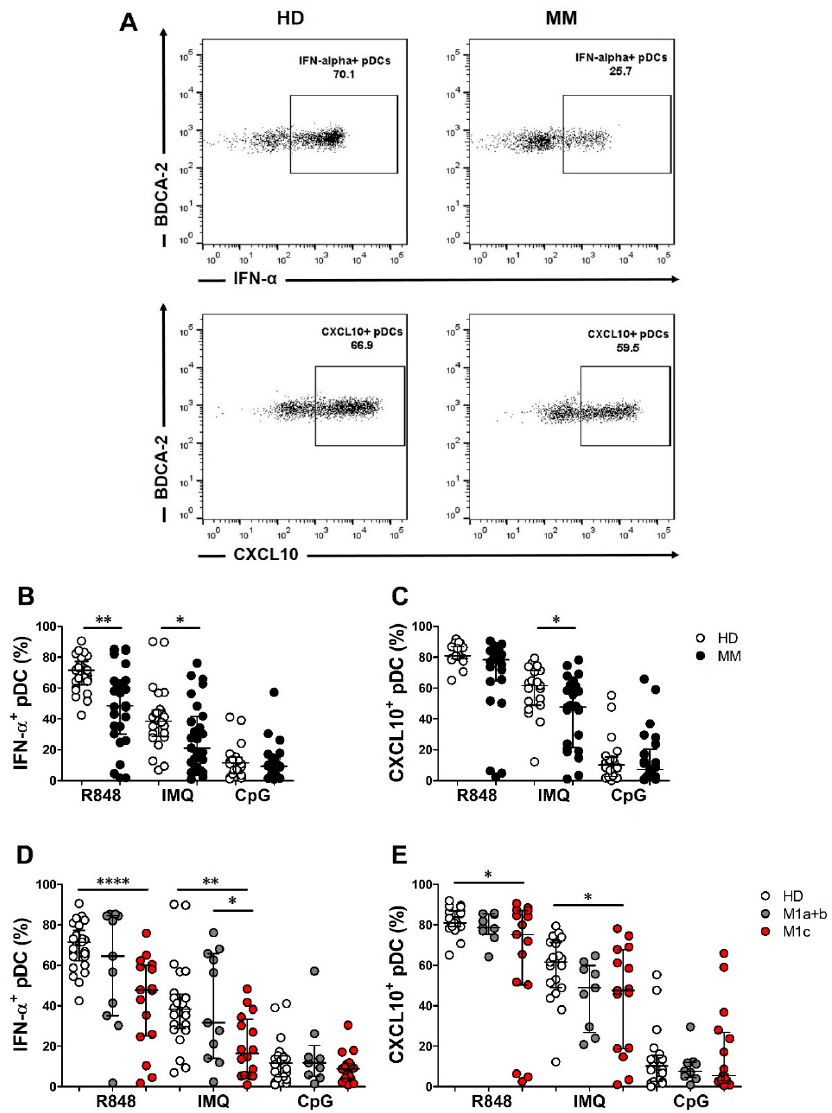
Figure 1. Frequency of interferon alpha (IFN- α ) and CXCL10-producing plasmacytoid dendritic cells (pDCs) in chemo-naïve MM patients and HD. Representative dot plots of R848-stimulated IFN- α + and CXCL10 + pDC subsets obtained from HD and MM patients are shown ( A ). PBMCs were isolated from peripheral blood of HD ( n = 25) and MM patients ( n = 29). Total PBMCs were cultured in RPMI 1640 medium supplemented with 10% FBS and IL-3 and stimulated with R848 or IMQ for 2 h ( B , D ) and 6 h ( C , E ), and with CpG-ODN 2216 for 6 h ( B – E ). IFN- α ( B , D ) and CXCL10 ( C , E ) were analyzed by intracellular flow cytometry staining. Scatter dot plot graphs illustrate the percentages of positive pDCs evaluated on BDCA-2 + / CD123 + cells. Subgroup analysis of the MM cohort illustrating the frequency of IFN- α + and CXCL10 + pDCs in M1a-c categories ( D , E ). Median and IQR are shown in ( B , C ). Mean and SD are shown in ( D , E ). The statistical significance was calculated by Wilcoxon–Mann–Whitney test ( B , C ) and by a Student’s t -test ( D , E ). * p < 0.05; ** p < 0.01; **** p <